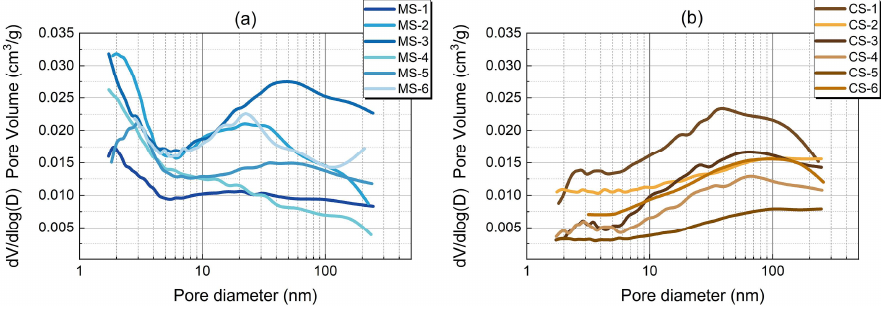
Figure 9. Pore size distribution based on N 2 adsorption of marine shale ( a ) and continental shale ( b ). There are both unimodal (MS-1, MS-4) and bimodal (MS-2, MS-3, MS-5, MS-6) distributions in marine shale, and all samples present unimodal distribution in continental shale.